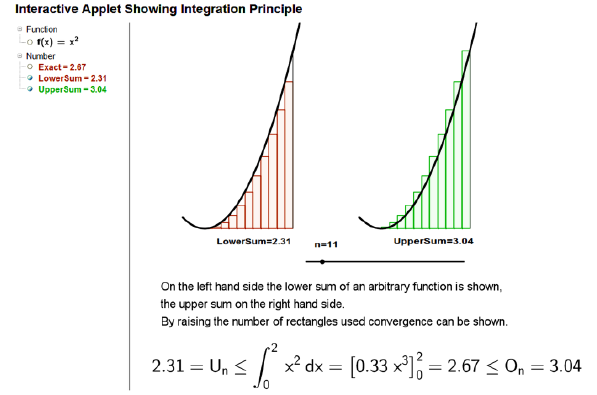
Figure 4. Interactive applet showing the integration